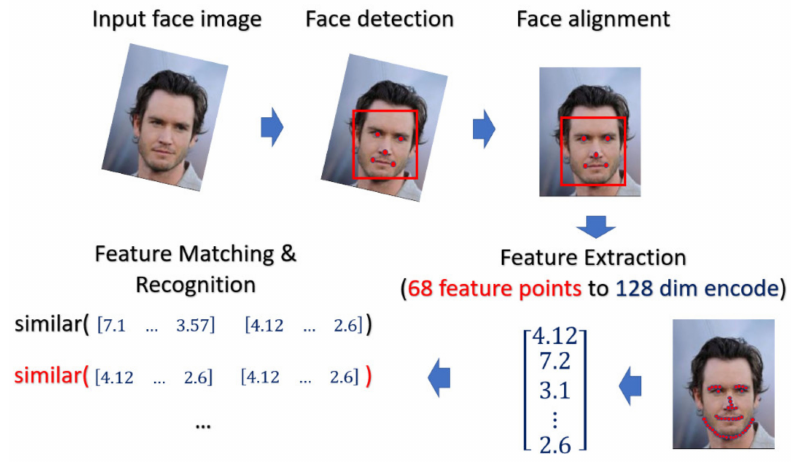
Figure 11. The flowchart of face recognition in our experiment.